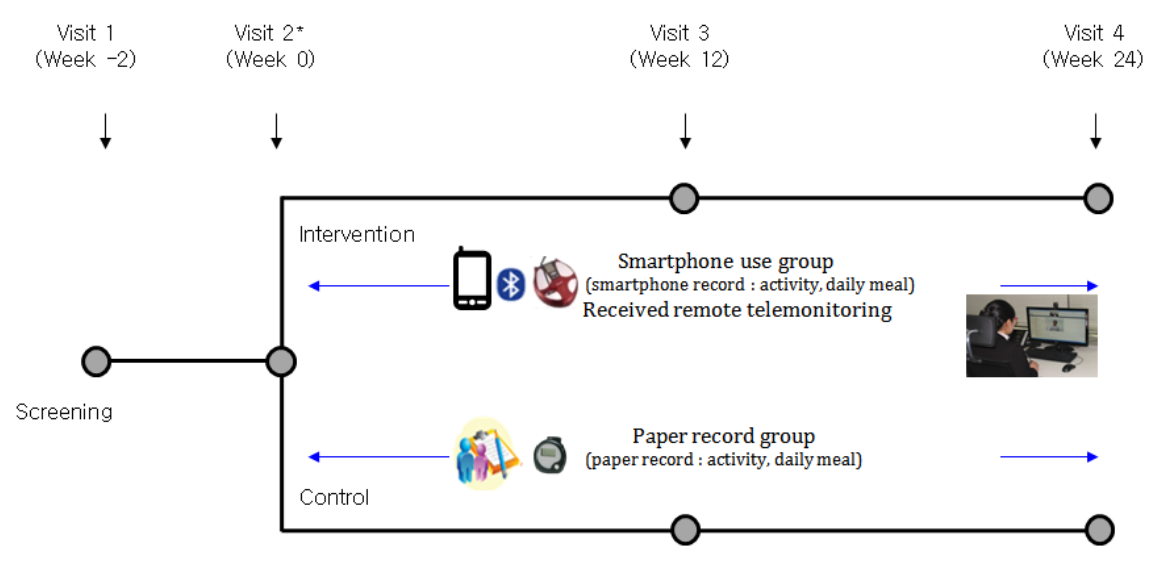
Figure 2. Flowchart of the